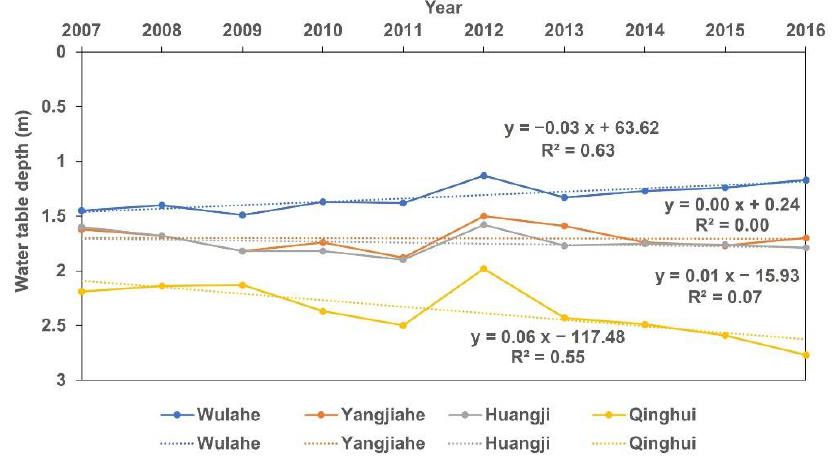
Figure 4. The cropping season average water table depth of the four sections in each year.